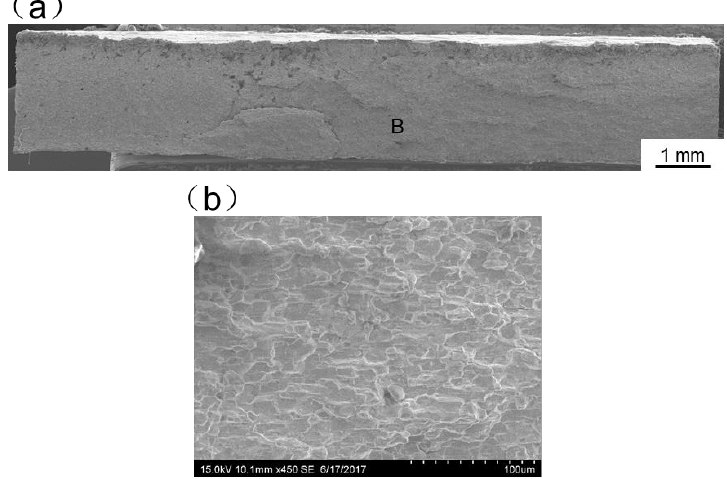
Figure 15. SEM images of tensile fracture when the offset is 0.25 mm (( a ) Overall morphology; ( b ) Magnified images of region B in panel ( a )).